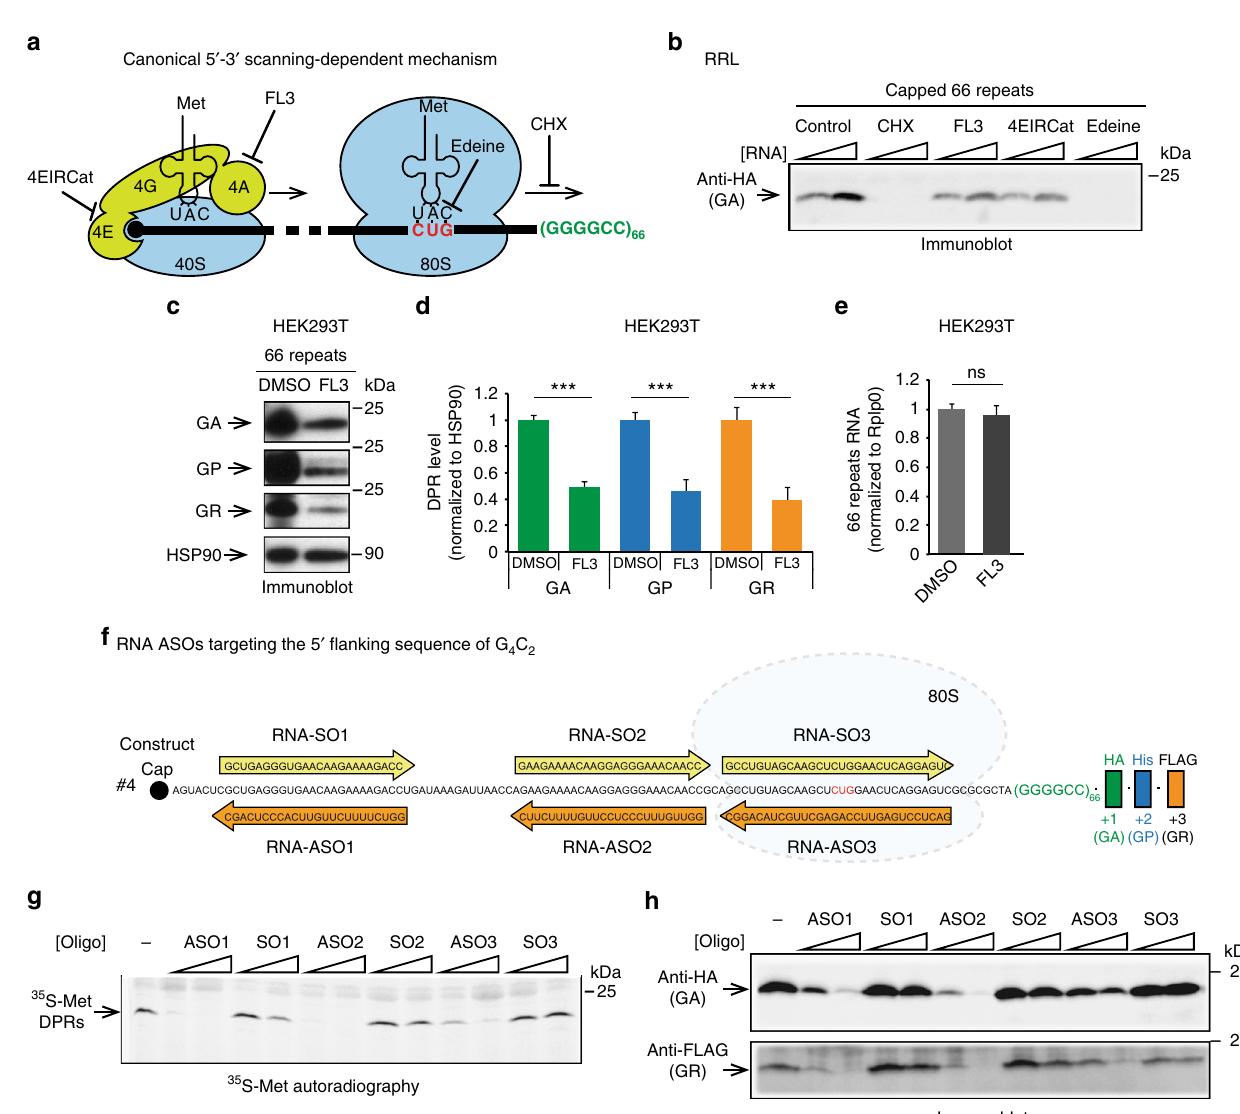
Fig. 6 Inhibition of RAN translation by eIFs inhibitors and RNA ASOs support a 5 ′ – 3 ′ scanning-dependent mechanism. ( a ) Illustration of translation inhibitors used to delineate the recruitment of the ribosome at the CUG start codon: 4EIRCat prevents the interaction between eIF4E (4E) and eIF4G (4G). FL3 inhibits RNA helicase eIF4A (4A). Edeine blocks the codon – anticodon interaction. Cycloheximide (CHX) blocks the translational elongation. ( b ) Translation was performed in presence of CHX, FL3, 4EIRCat, or Edeine in RRL followed by immunoblot detection of anti-HA (poly-GA) antibody. ( c – e ) HEK293T cells were transfected with the construct #4 expressing 66 G 4 C 2 repeats and treated with FL3 or DMSO control. ( c ) Immunoblots using antibodies against poly-GA, poly-GP, poly-GR, and HSP-90 proteins. ( d ) Levels of poly-GA, poly-GP, and poly-GR after FL3 treatment were quanti fi ed and normalized to HSP90 and DMSO-treated cells. Graphs represent mean ± SEM, n = 5. Student ’ s t -test, *** indicate p < 0.001. ( e ) Levels of repeat- containing transcripts determined by quantitative RT-PCR and normalized to the Rplp0 transcripts and DMSO treated cells. ( f ) Schematic representations of construct #4 with sequences of sense (RNA-SO) and antisense (RNA-ASO) RNA oligonucleotides used to inhibit RAN translation. ( g – h ) Translation of capped (G 4 C 2 ) 66 RNAs (construct #4) was performed in RRL in presence of two concentrations of sense or antisense RNA oligonucleotides. ( g ) [ 35 S]- methionine RAN translation products were detected by autoradiography. ( h ) Poly-GA and poly-GR were detected by immunoblot using anti-HA (Poly-GA) and -FLAG (Poly-GR) antibodies,